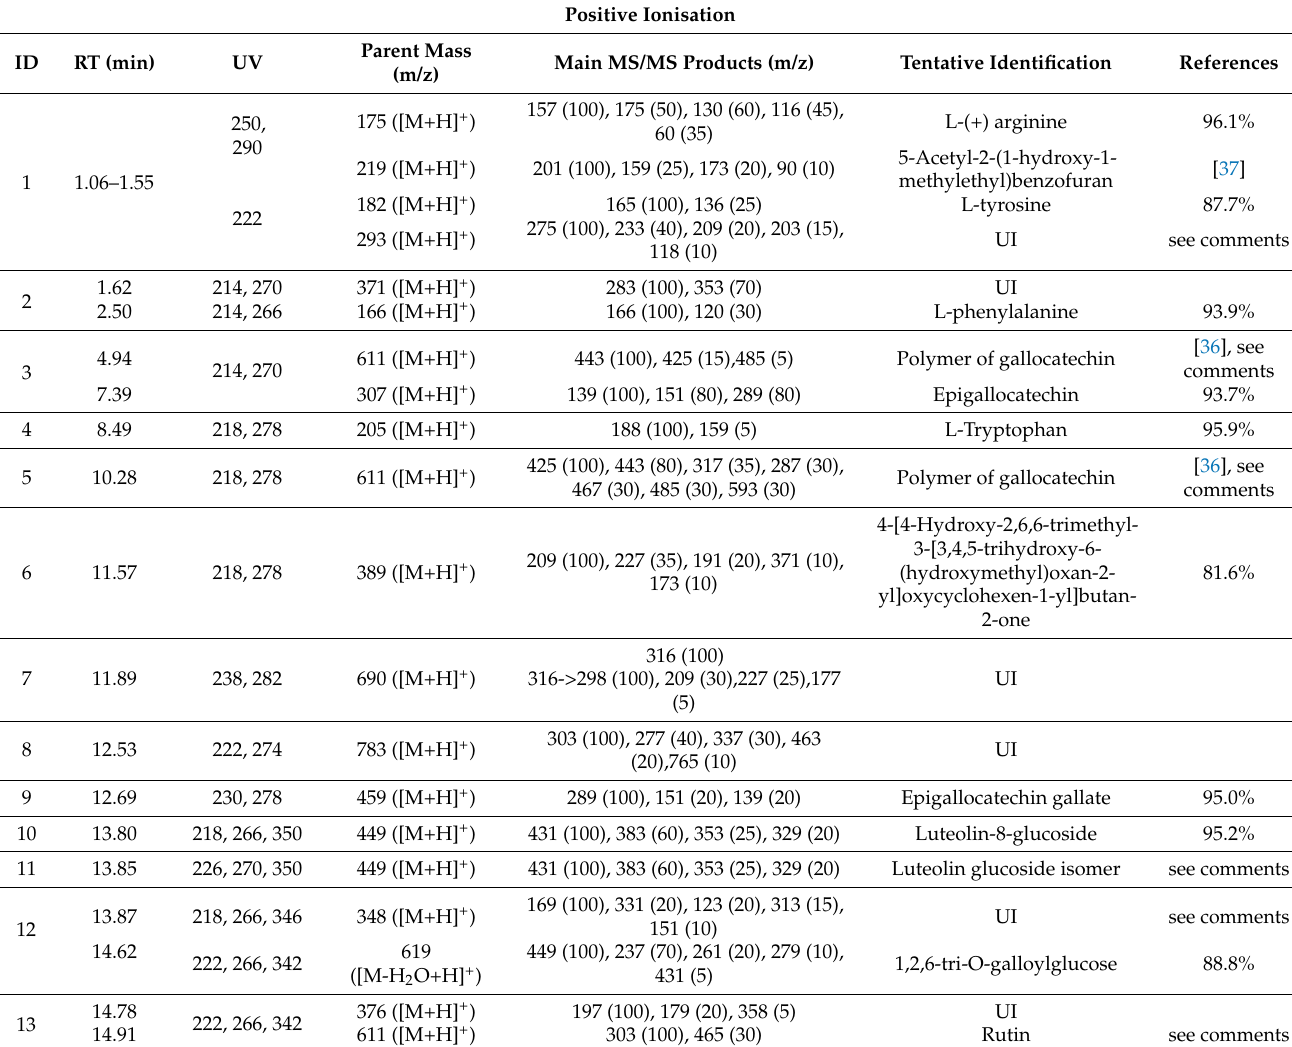
Table 6. Metabolites identified in Pelargonium odoratissimum (L.) L’H é r by HPLC-ESI-MS/MS in positive and negative ionisation